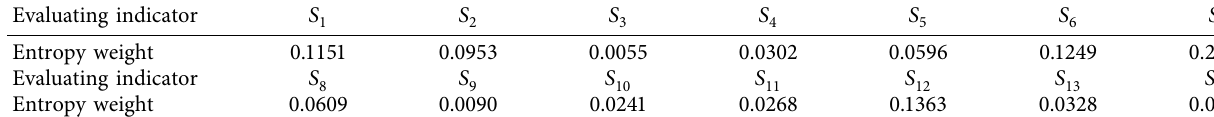
Table 4: Entropy of evaluation